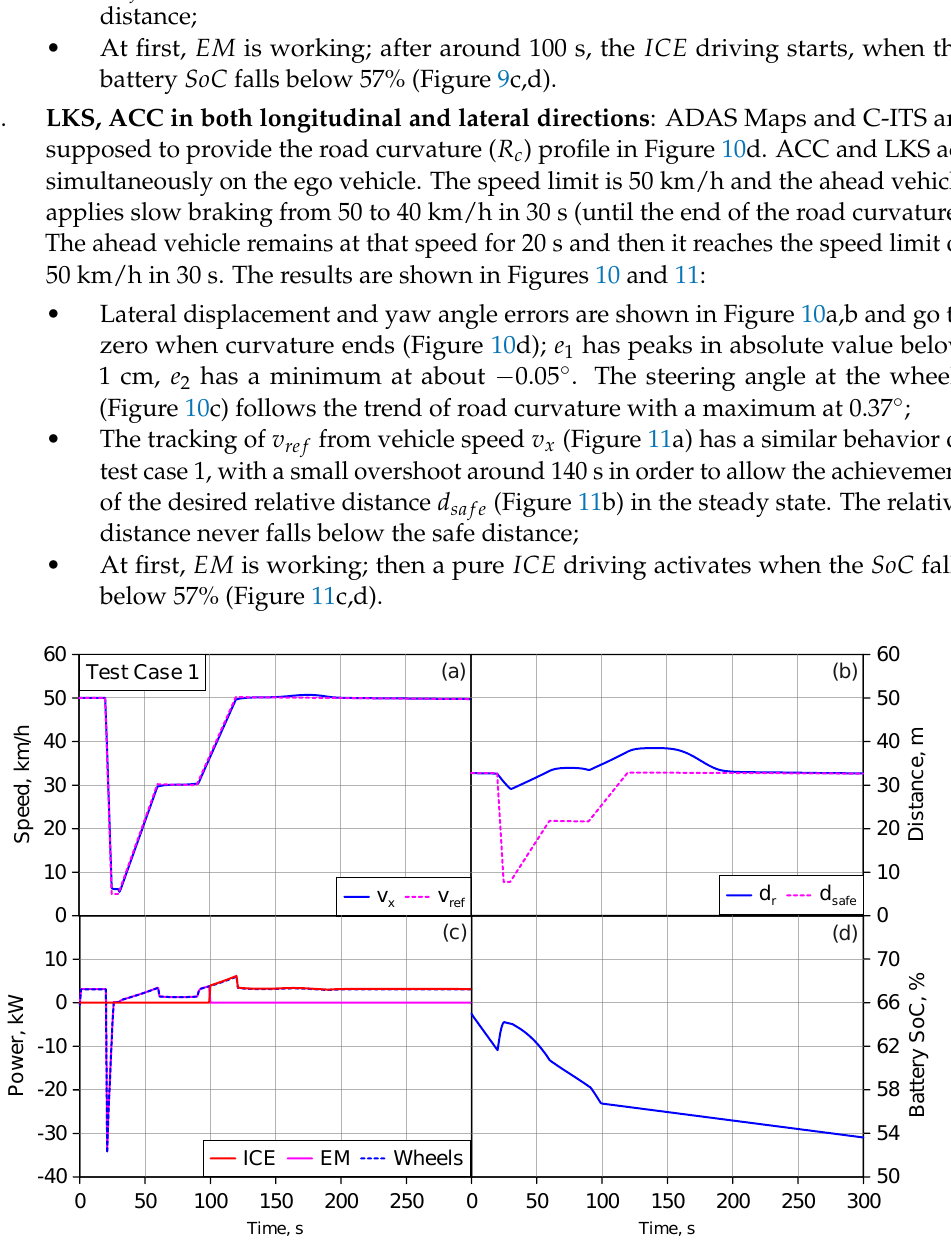
Figure 9. Test case 1: ( a ) speed (km/h); ( b ) relative distance (m); ( c ) ICE/EM/Wheels power (kW); ( d ) battery SoC